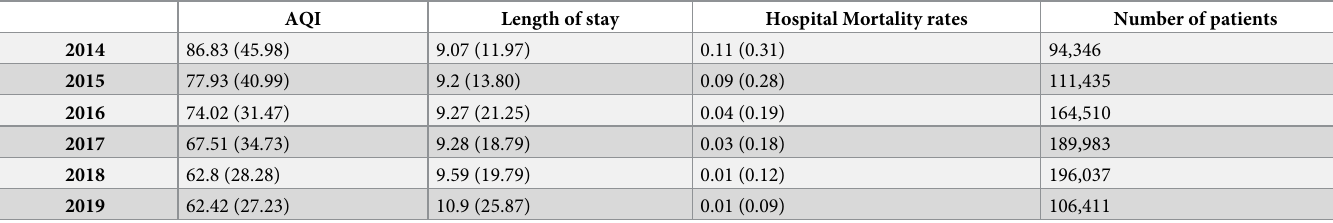
Table 2. Descriptive statistics of air quality index, length of stay, hospital mortality rates and number of patients from January 2014 to June